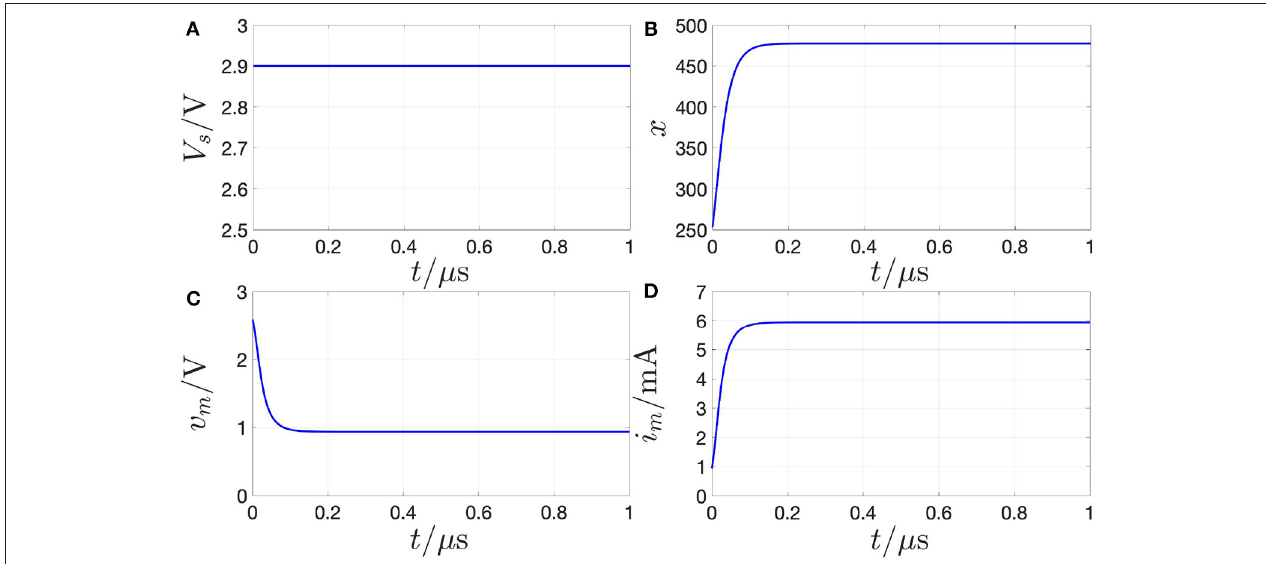
( V m , I m ) (0.937V,5.948mA) under voltage control on the basis of a numerical = = 330 (cid:127) is inserted between the source, generating a =